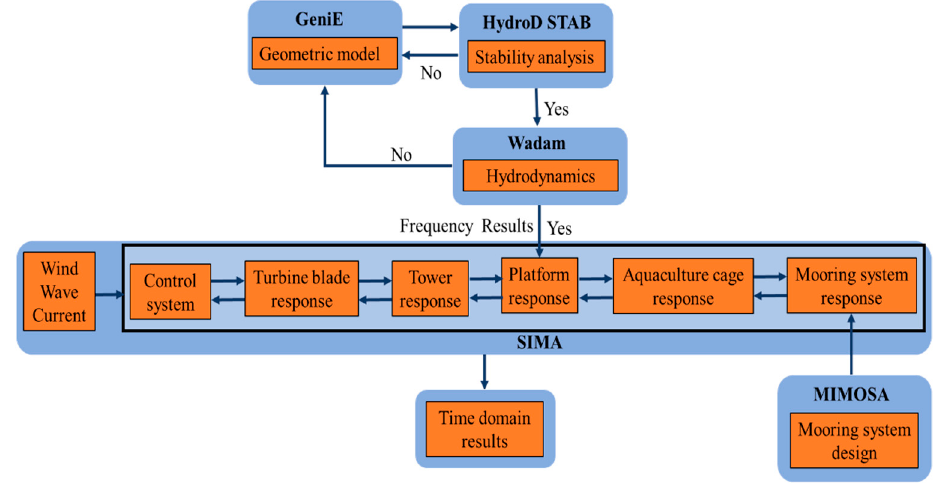
Figure 3. Concept design process of the LSBT-FOWT-AC.